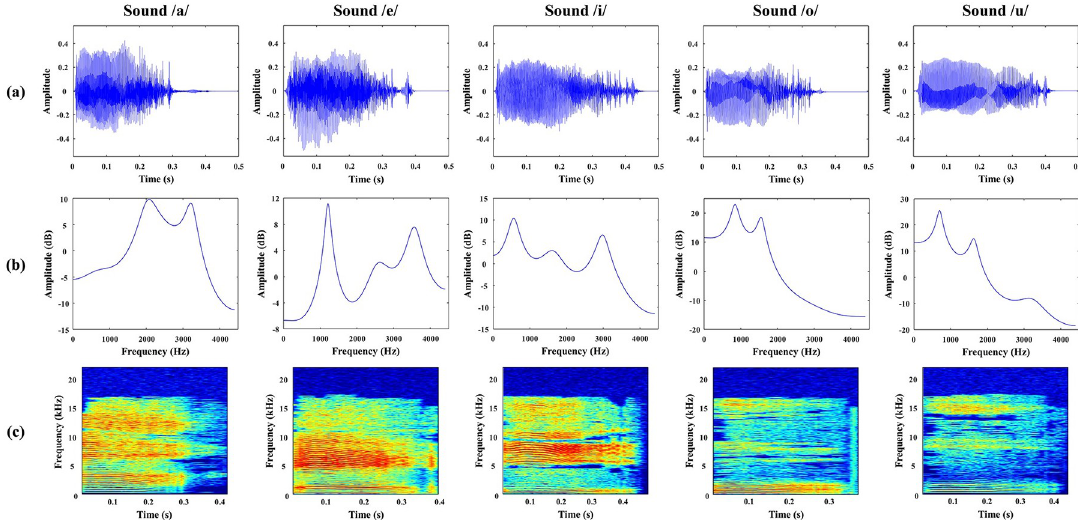
Fig 1. Characteristics of each vowel speech sound. (a) Time course, (b) linear predictive coefficient (LPC) spectra, and (c) the spectrogram of five vowel sounds used in this experiment. The peaks of LPC spectra refer to the formant frequencies of the sound stimuli. Vowel /a/ shows peaks at F1 = 651 Hz, F2 = 2034 Hz, F3 = 3234 Hz; vowel /e/ at F1 = 1211 Hz, F2 = 2559 Hz, F3 = 3570 Hz; vowel /i/ at F1 = 559 Hz, F2 = 1630 Hz, F3 = 2988 Hz; vowel /o/ at F1 = 845 Hz, F2 = 1564 Hz, F3 = 2921 Hz; vowel /u/ at F1 = 699 Hz, F2 = 1636 Hz, F3 = 3299